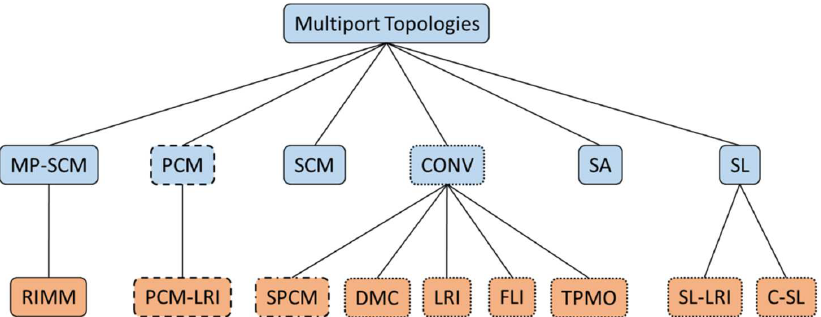
Figure 12. Classification of multiport topologies. ( Blue ) Without fault tolerance strategies. ( Orange ) With fault tolerance strategies.